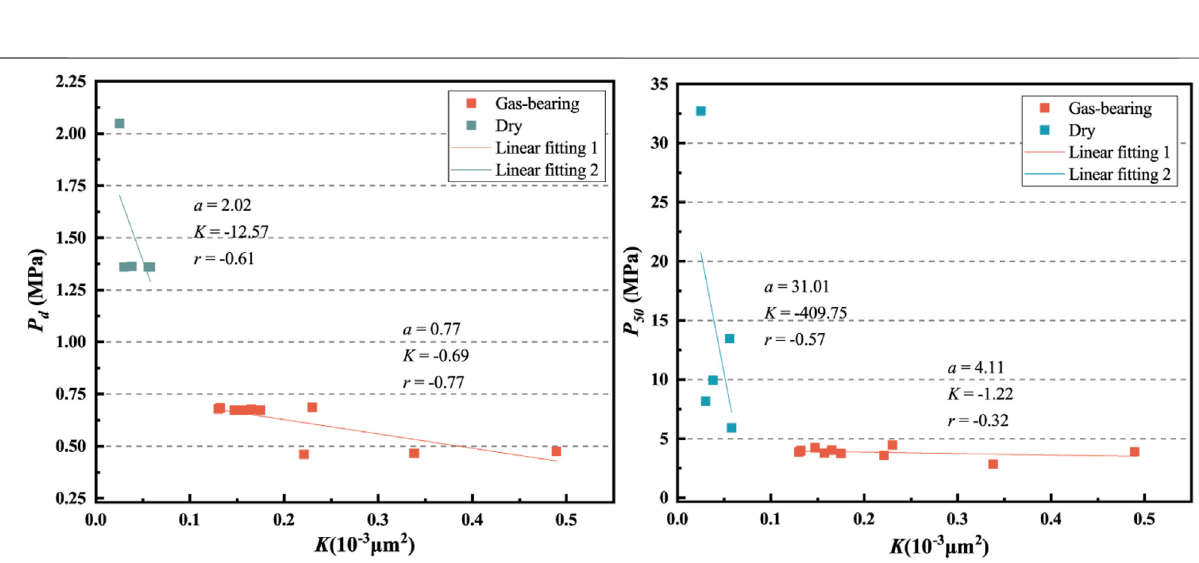
Frontiers in Earth Science |